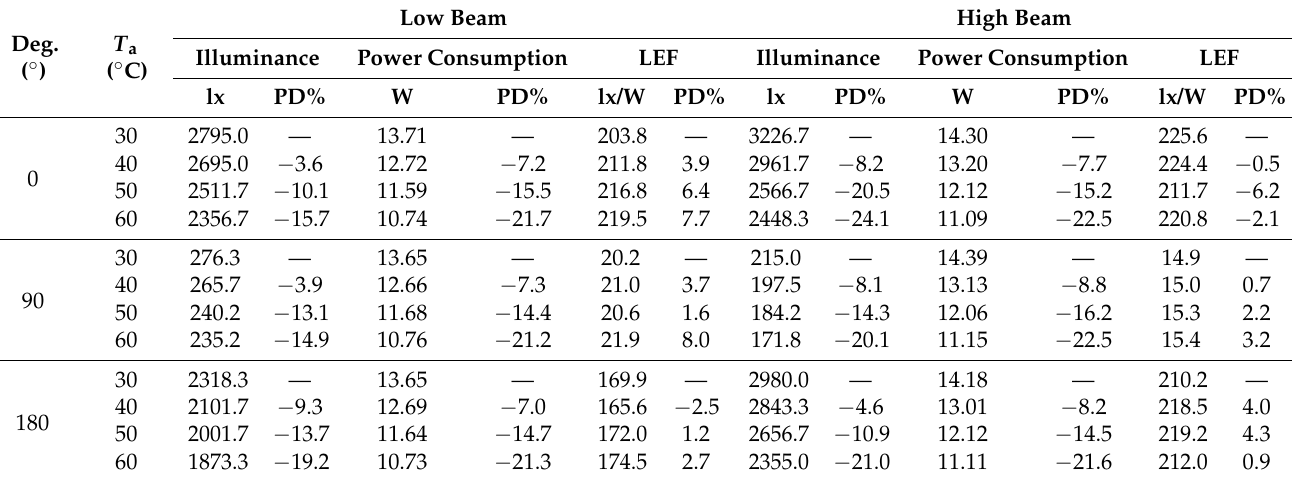
Table 3. Illuminance, power consumption, and lighting efficiency of the LED